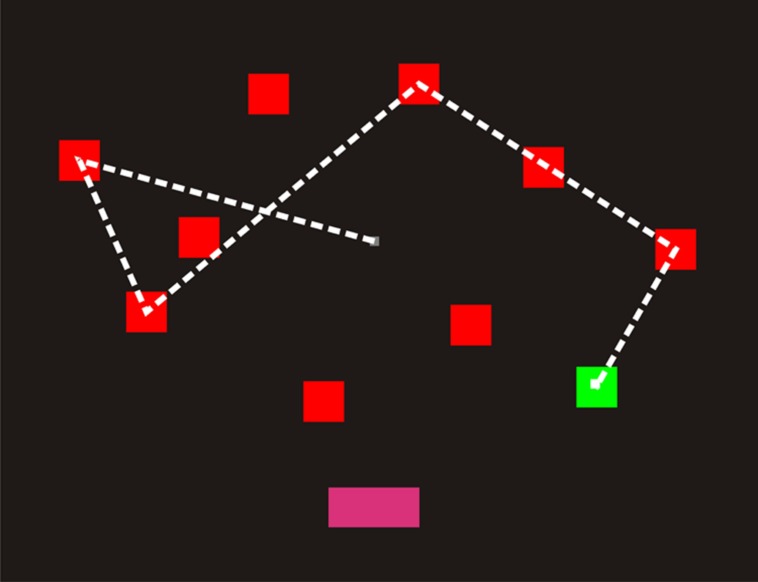
A computerized spatial span test (C-SST) sequence of length five. The square sequence was shown to participants using the cursor (a small white square), which moved from square to square over 977 ms intervals. Each square flashed green as it was selected (bottom right). When the sequence had been shown, the “Done” button illuminated (bottom center). The participant’s task was to select the squares in the correct order using the mouse. The dashed line has been included to illustrate the cursor displacements, but was not visible to participants. Participants clicked “Done” when their selection was complete.